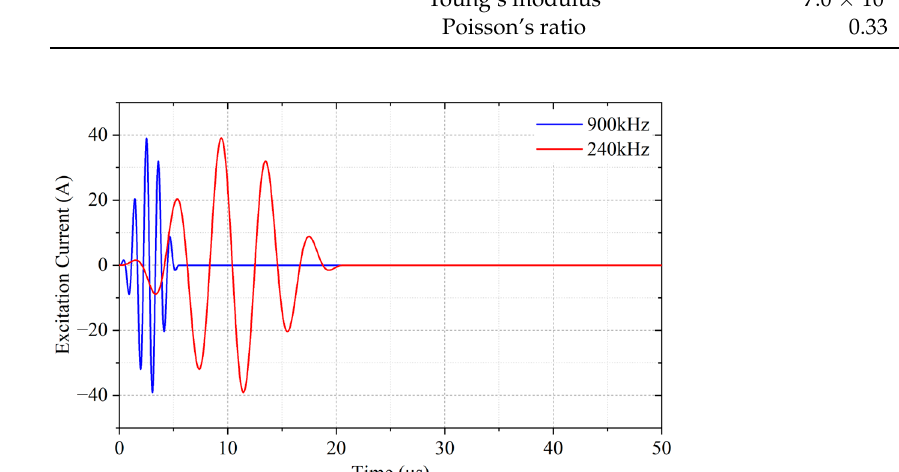
Figure 4. Excitation signals used in the simulations. The signal at 900 kHz is used in the WBM model, and the signal at 240 kHz is used in the WBG model.